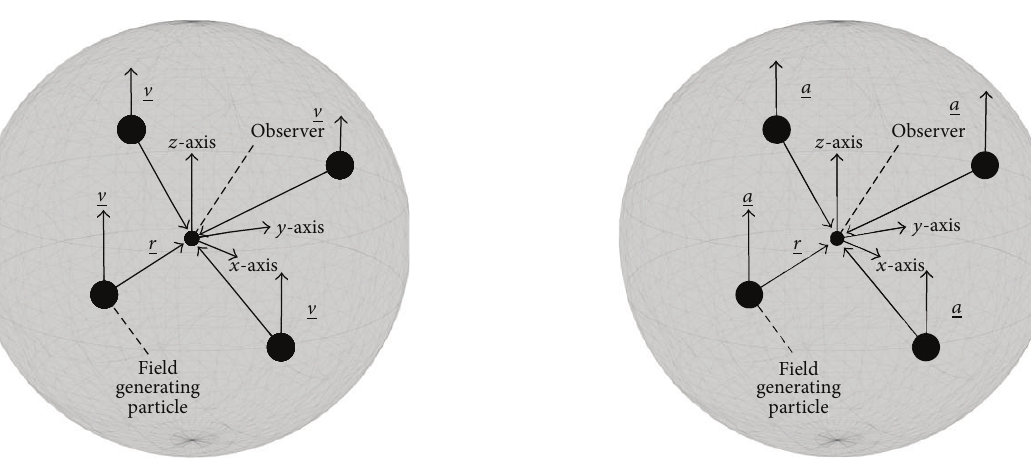
Figure 4: When the observer accelerates, the universe appears to instantaneously